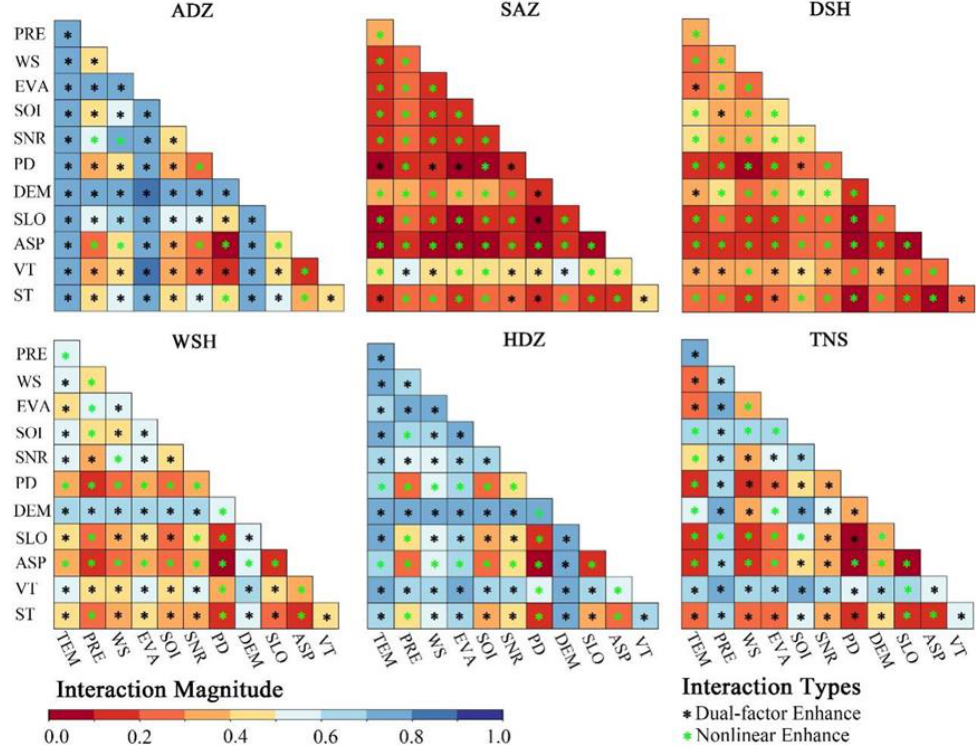
Figure 9. Effect of two-factor interaction on the change of VEQI in the TNS and each climate zone. The optimal types and range of drivers favoring the maintenance of VEQ in the TNS and each climate zone were analyzed based on the risk detector (Figure 10, Table S3). For